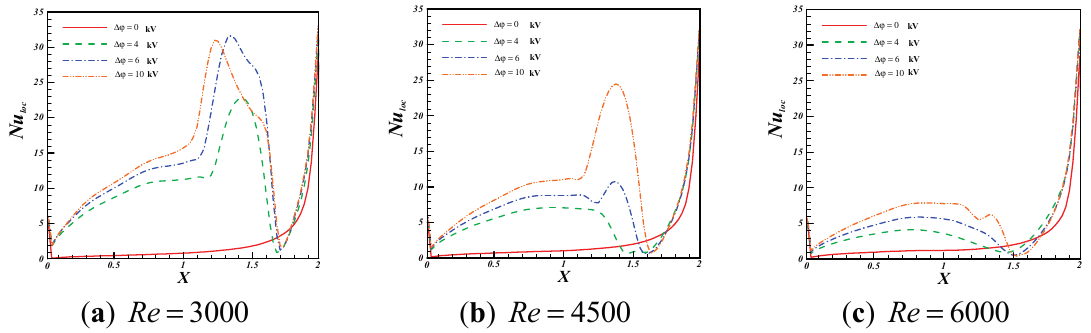
Figure 7. Effects of Reynolds number and supplied voltage on local Nusselt number for ( a